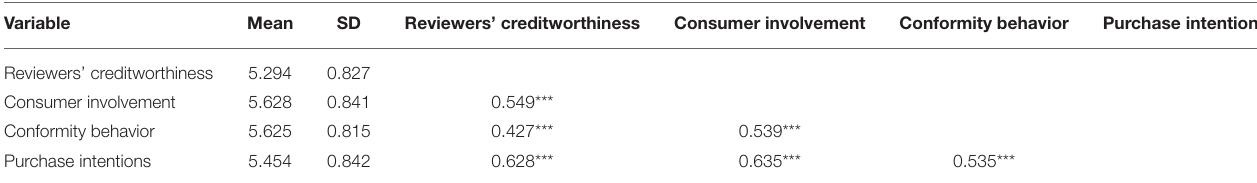
TABLE 3 | Descriptive statistics and correlation